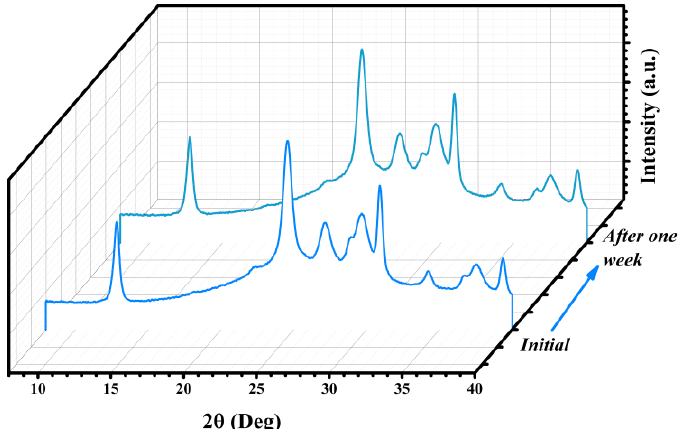
Figure 6. Initial XRD results of PyPbI 3 , and results after one week in ambient conditions with a RH of 50%.